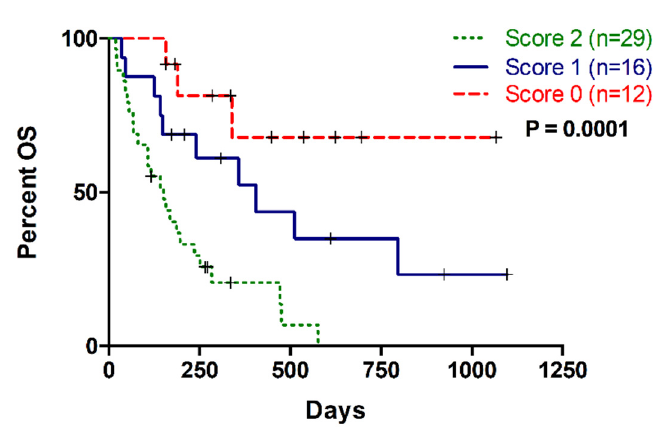
Figure 7. Multi-parametric analysis combining CA19-9 and cfDNA based liquid biopsy markers (MAF, cfDNA concentration and cfDNA fragmentation). Score 0: no positive markers; Score 1: One positive marker; Score 2: More than one positive markers.